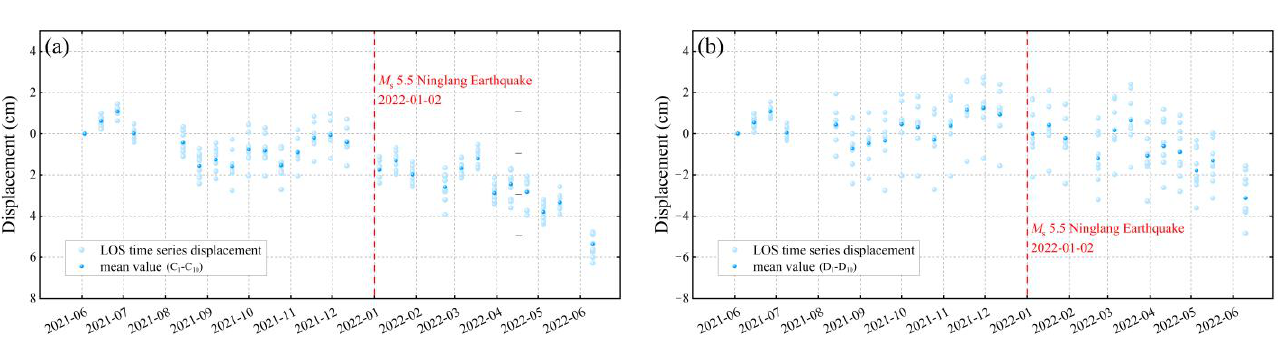
Figure 8. The displacement time series before and after the earthquake of the descending InSAR. C and D are the areas where the 20 selected deformation points (C 1 –C 10 , D 1 –D 10 ) in Figure 9 are located.